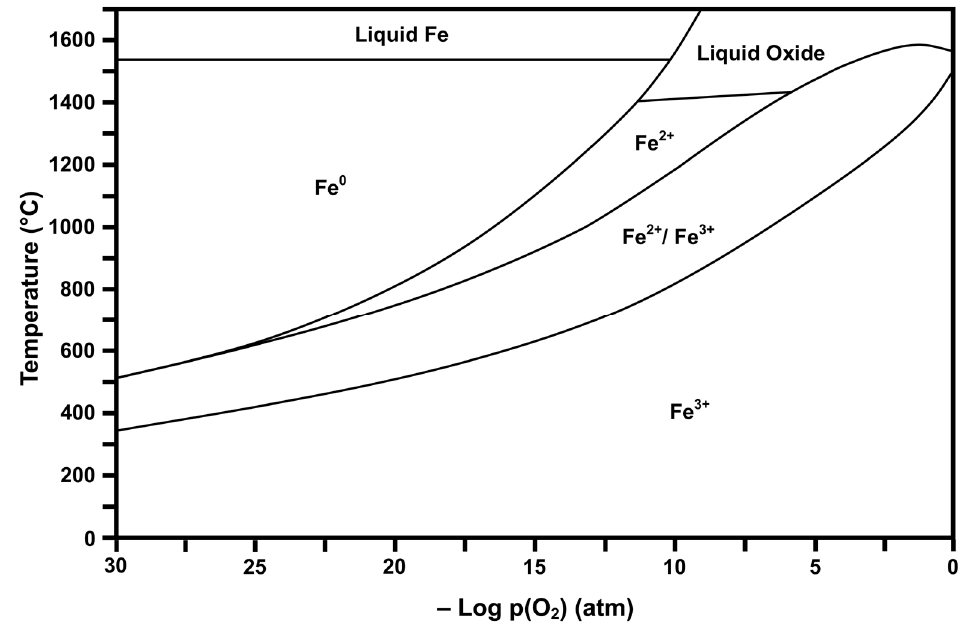
Figure 3. Calculated Fe stability diagram (Fe 3+ = Fe 2 O 3 , Fe 2+ /Fe 3+ = Fe 3 O 4 or FeO ∙ Fe 2 O 3 , Fe 2+ = FeO, Fe = elemental Fe).